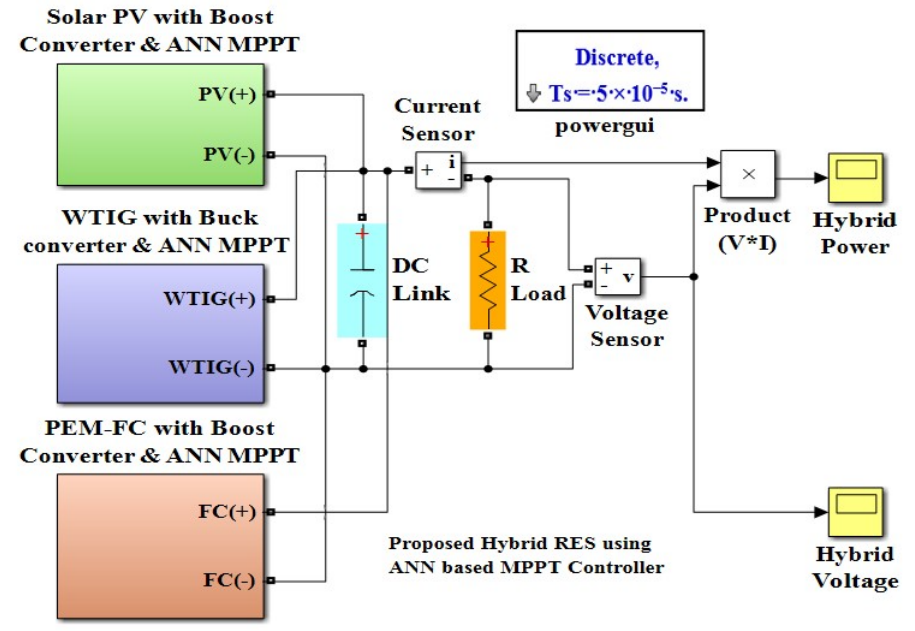
Figure 23. Modelling of Proposed Hybrid RES with AN-N MPPT.